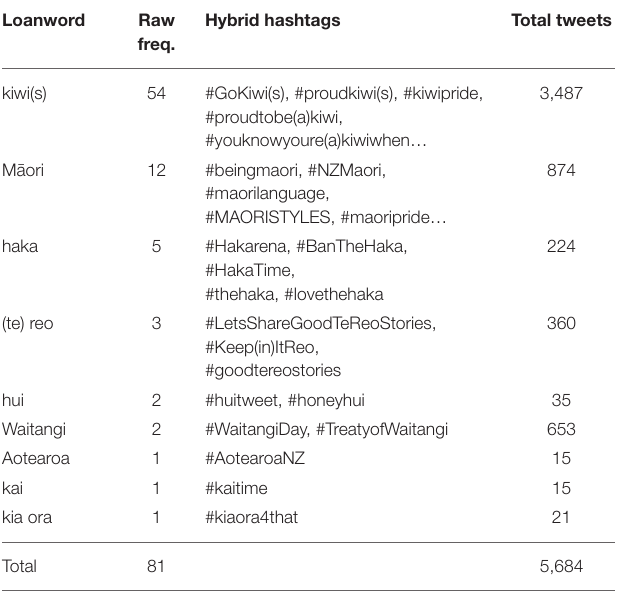
TABLE 3 | Usage statistics for the nine M¯aori loanwords present in the set of hybrid hashtags. Loanword Raw